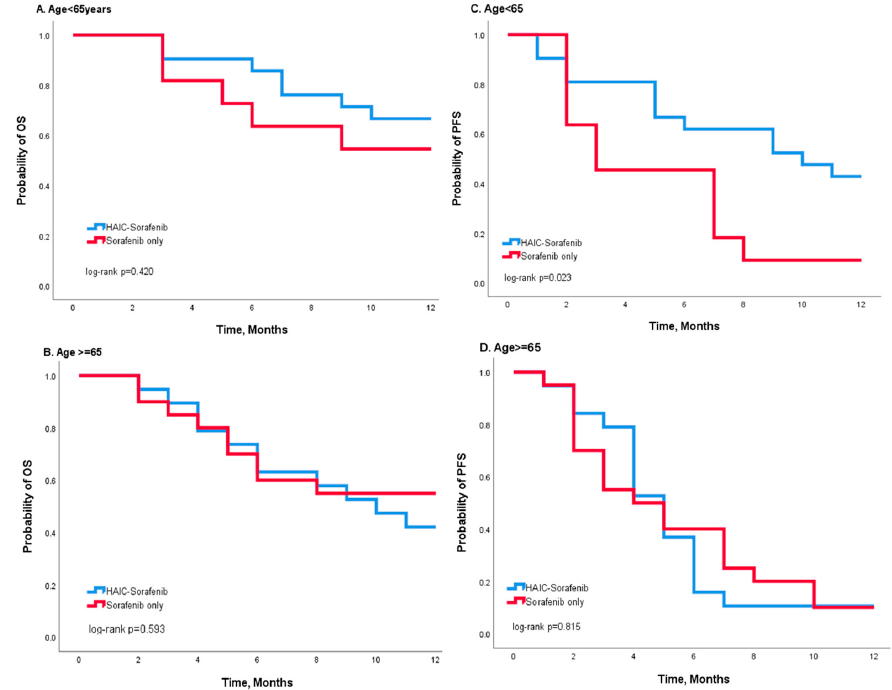
Figure 3. Kaplan–Meier survival analysis according to different treatments (HAIC-sorafenib versus sorafenib alone) for patients of different age groups: ( A , B ) OS and ( C , D ) PFS. Among those younger than 65 years, the survival curves show a better OS and PFS in the combination group ( A , C ), and the log-rank test indicates a significant difference in PFS ( p = 0.023 in ( C )). Among those aged 65 and older, the log-rank test shows no significant differences between the survival curves ( B , D ).